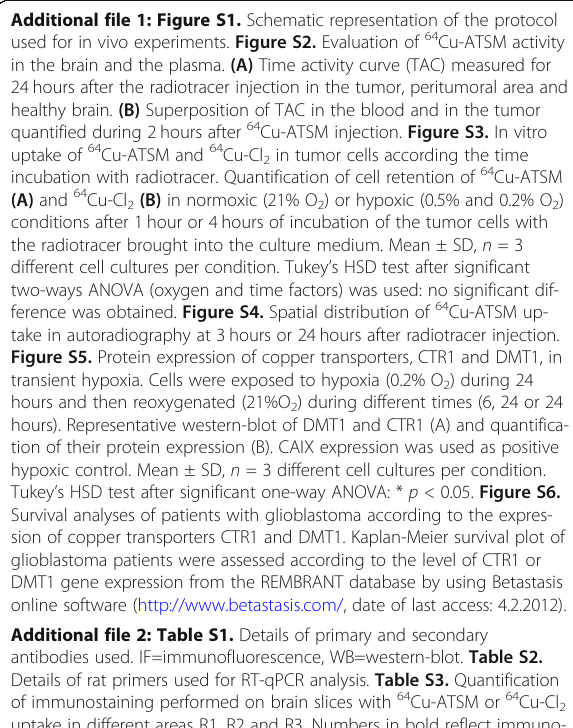
Additional file 1: Figure S1. Schematic representation of the protocol used for in vivo experiments. Figure S2. Evaluation of 64 Cu-ATSM activity in the brain and the plasma. (A) Time activity curve (TAC) measured for 24hours after the radiotracer injection in the tumor, peritumoral area and healthy brain. (B) Superposition of TAC in the blood and in the tumor quantified during 2 hours after 64 Cu-ATSM injection. Figure S3. In vitro uptake of 64 Cu-ATSM and 64 Cu-Cl 2 in tumor cells according the time incubation with radiotracer. Quantification of cell retention of 64 Cu-ATSM